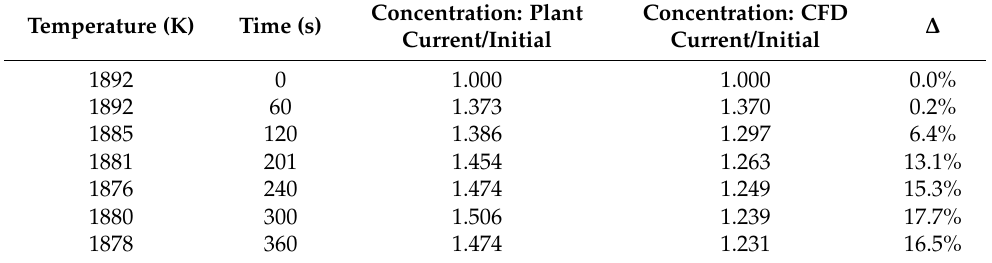
Table 2. Scaled copper recovery data.